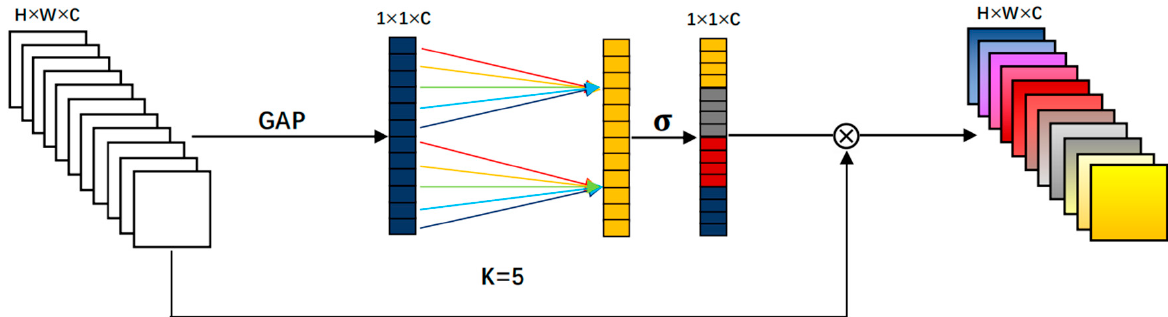
Figure 3. Effective channel attention